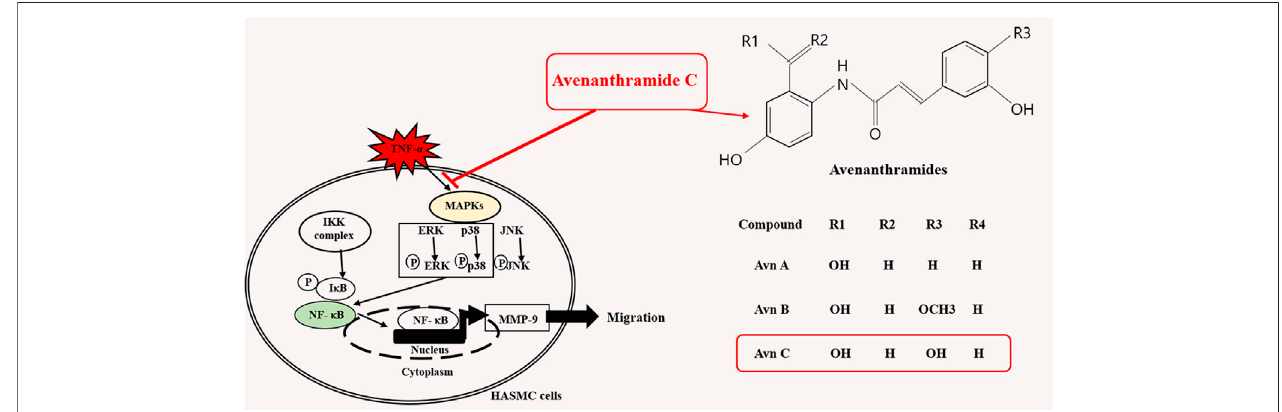
FIGURE 7 | A schematic illustration of anti-atherosclerosis action of Avn